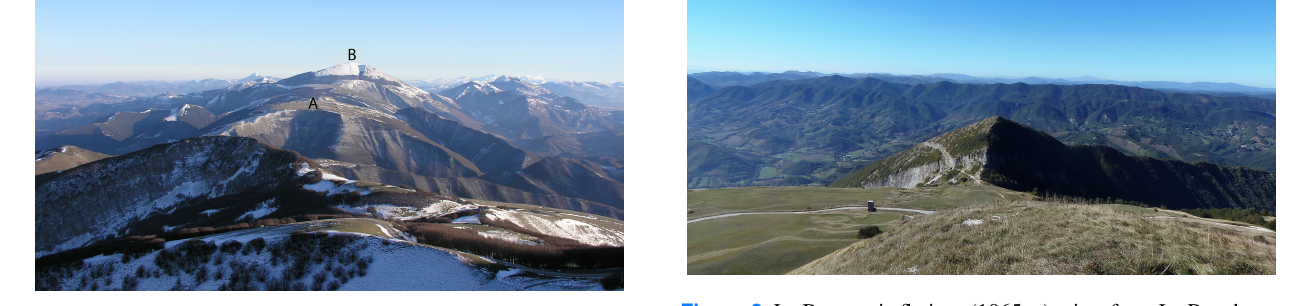
Figure 6. The Catria–Nerone mountains’ anticline ridge (oriented NW–SE), with the view from Mount Nerone (NW). Note: A – Mount Petrano (1162m); B – Catria Massif (1701m).